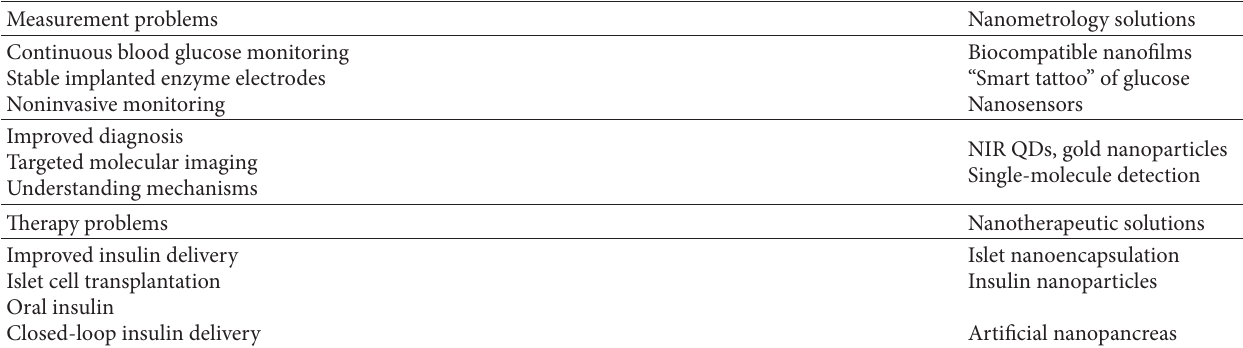
Table 2: Description of some problems associated with diabetes and possible nanomedicine